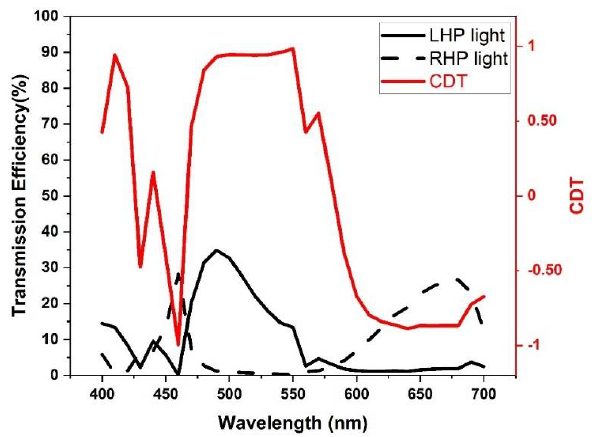
Figure 5. The transmission efficiency of LHP, RHP light and CDT of 5−layer nanocuboids.